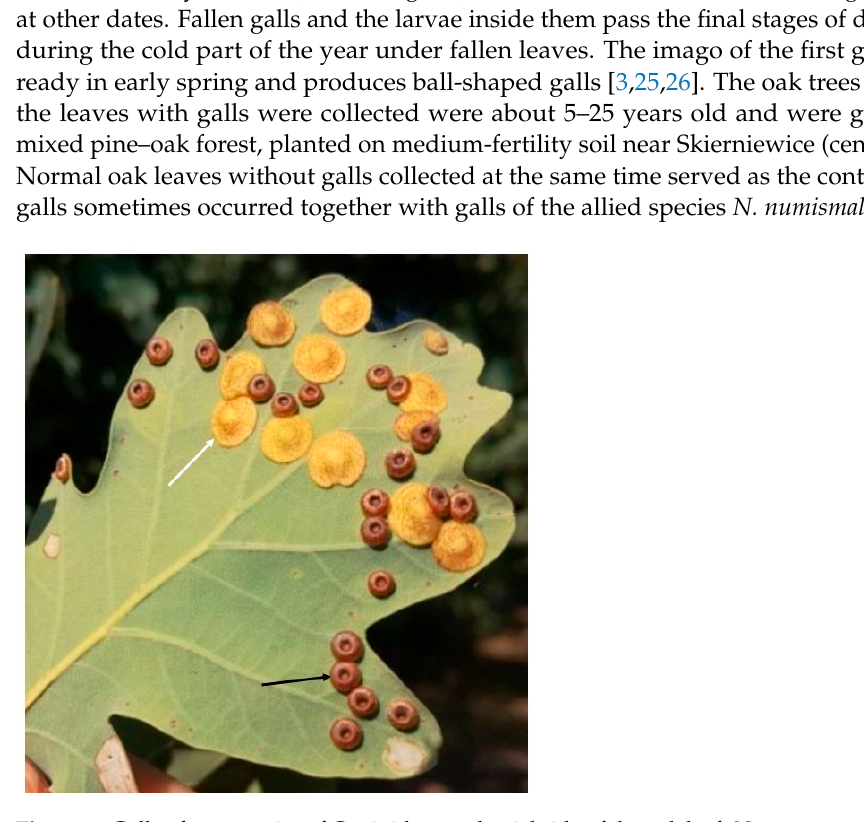
Figure 1. Galls of two species of Cynipidae on abaxial side of the oak leaf: Neuroterus quercusbaccarum , spangle gall (white arrow); N. numismalis (black arrow). Picture at mid-August.